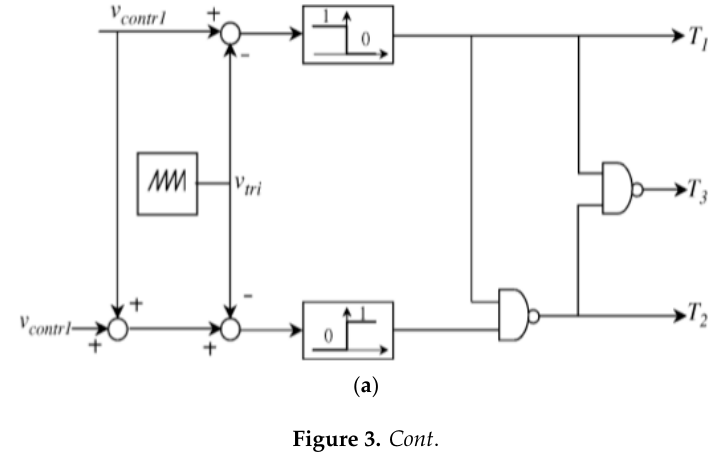
Figure 2. Relationships among v 1 , v 2 and v 3 voltages and switch on-duty ratios.